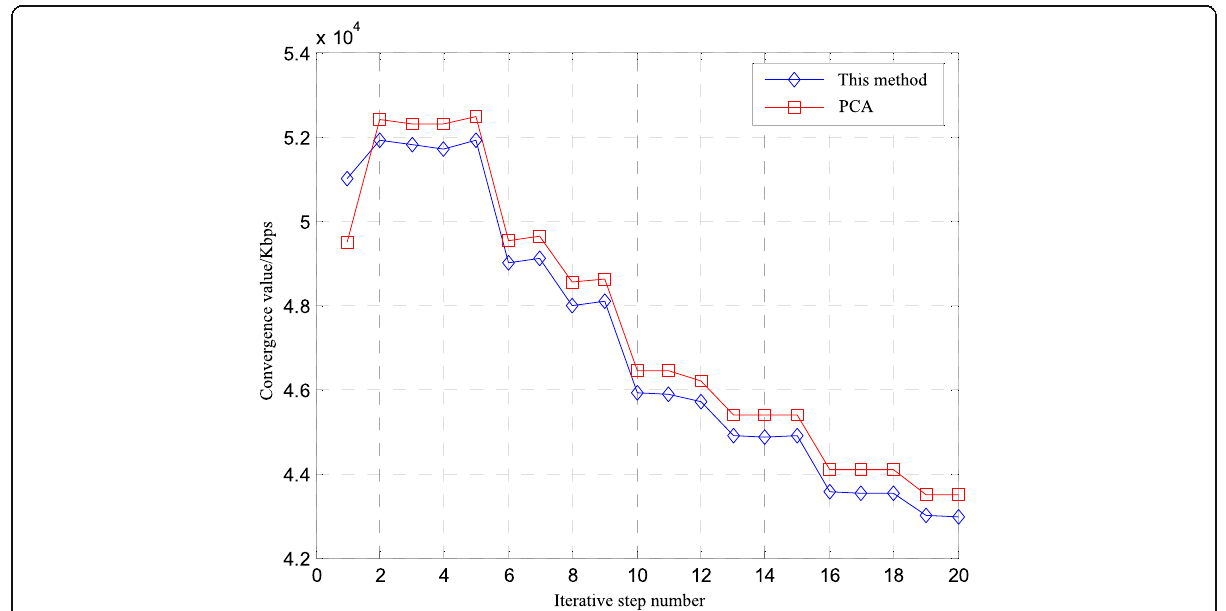
Fig. 3 Comparison of convergence curves of data mining. Figure shows the convergence of different methods for web data mining is